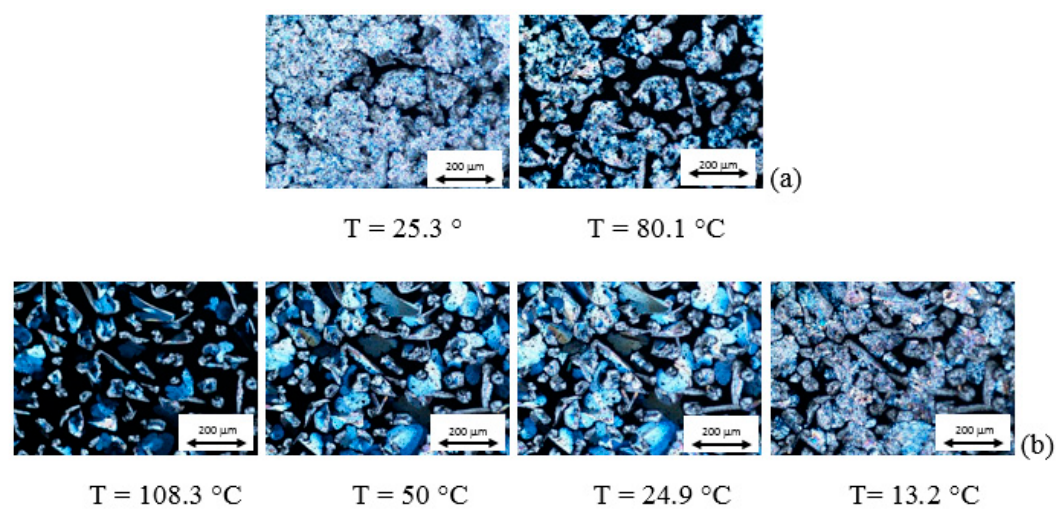
Figure 6. Photomicrographs of the optical textures registered at various temperatures for the AZJ1:TiO 2 (anatase) during heating ( a ) and cooling ( b ) at rate 10 ◦